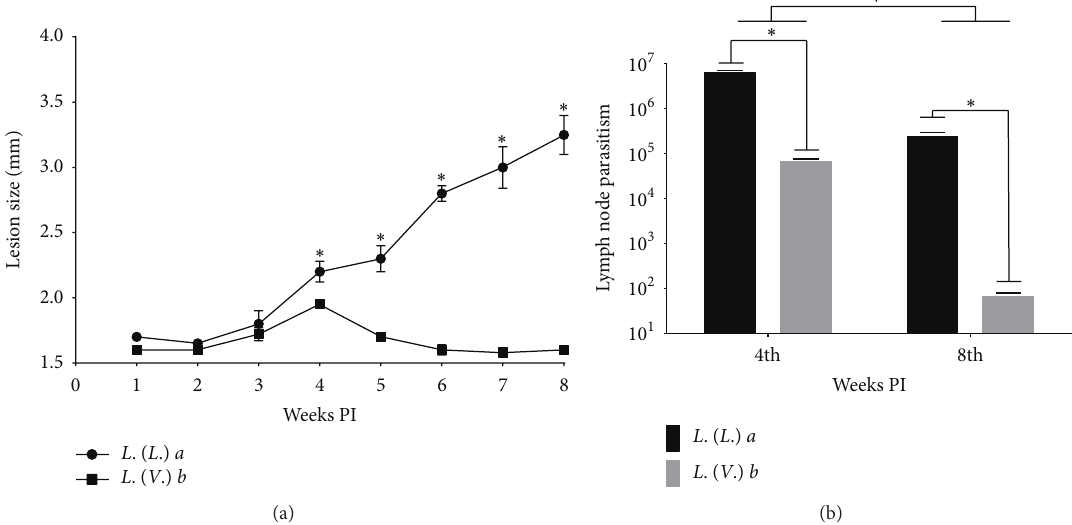
Figure 1: L. (L.) amazonensis and L. (V.) braziliensis infection in BALB/c mice. (a) The evolution of the lesion size (mm) in the hind footpad of mice infected with L. (L.) amazonensis or L. (V.) braziliensis . (b) Parasite load (number of parasites/mg of tissue) in the draining lymph nodes of mice infected with L. (L.) amazonensis or L. (V.) braziliensis . Each data point represents the mean ± standard deviation for the respective experimental group. ∗ 𝑝 < 0.05